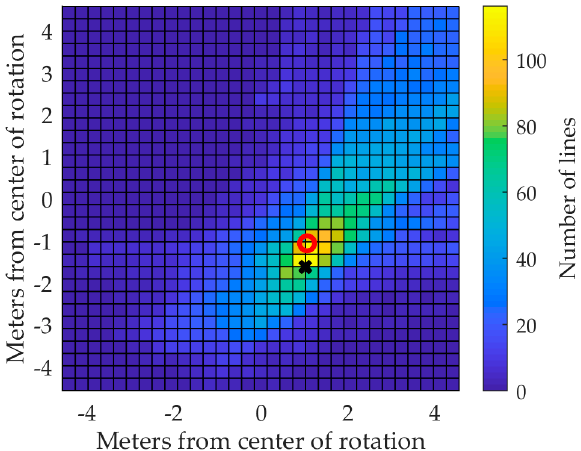
Figure 3. Wind-based location method: Lines projected upwind from high methane points converge on the leak source. The red circle represents the known actual leak location (here 1 m south and 1 m east of center), and the black x shows the system-estimated leak location.